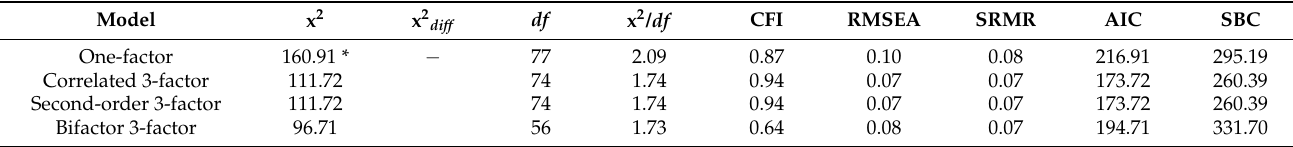
Table 3. CFA goodness-of-fit indicators.